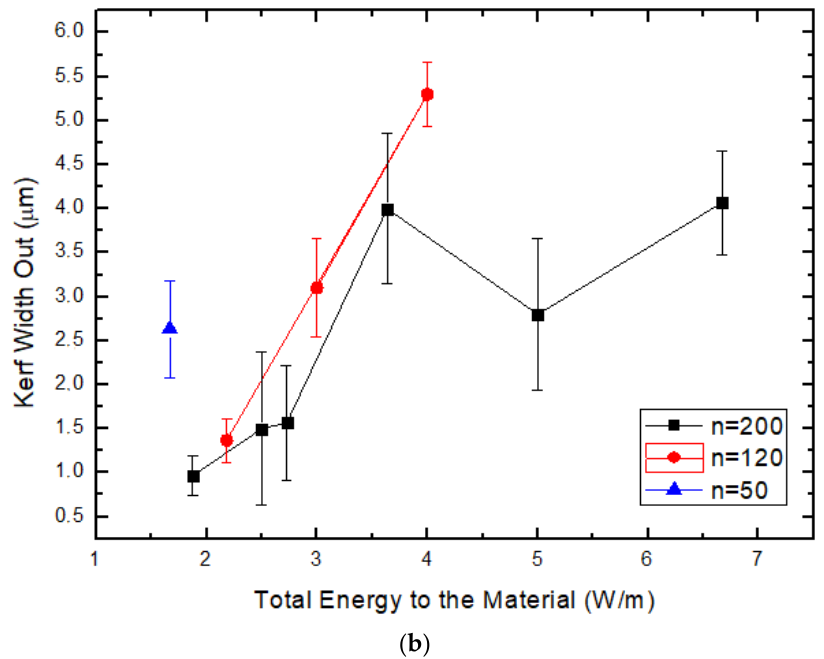
Figure 3. Kerf width on the ( a ) entry and ( b ) exit sides of the cut versus the total energy supplied to the material.